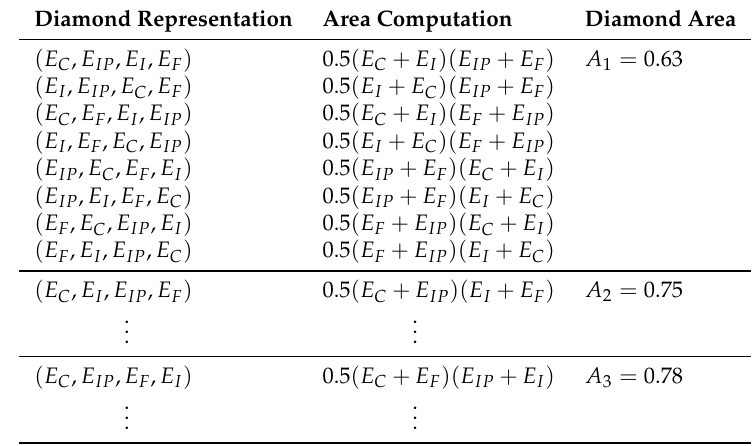
Table 3. Equivalence classes for the diamond representation of the perspectives performance scores of a museum with respect to the diamonds area (for the second and third class, only one representative diamond is reported); the area in the last column is computed for the instance E C = 1, E IP = 0.5, E I = 0.8, E F =